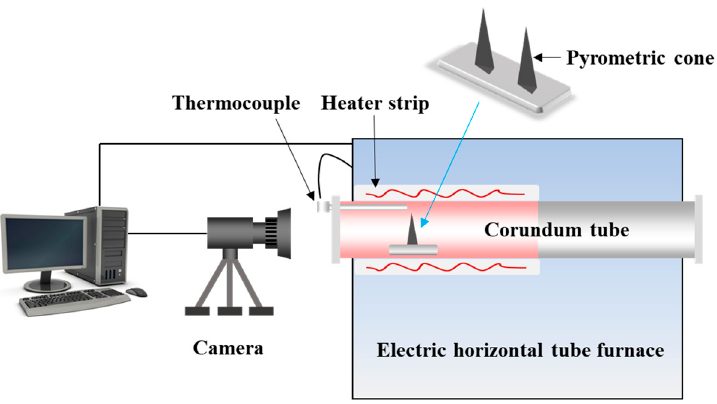
Figure 1. Schematic diagram of ash fusion apparatus for evaluating the softening ‐ melting perfor ‐